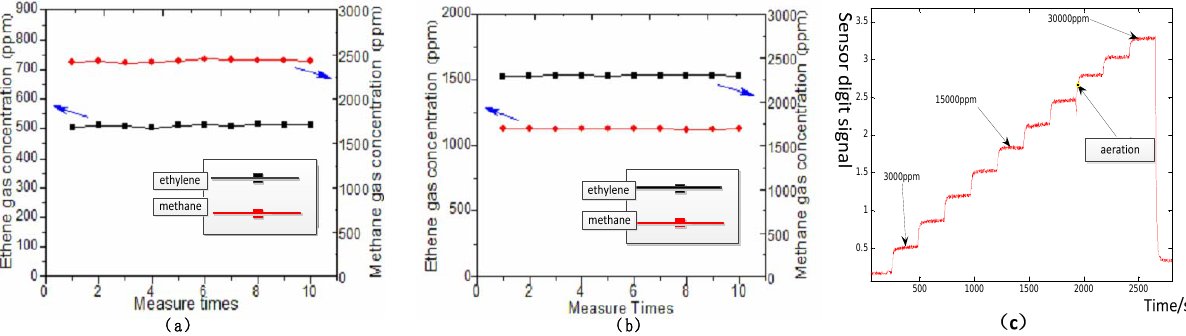
Figure 9. ( a ) Results of sensor repeatability test ( b ) Results of sensor stability test ( c ) Dynamic response of IR detector to gas concentration in the experimental